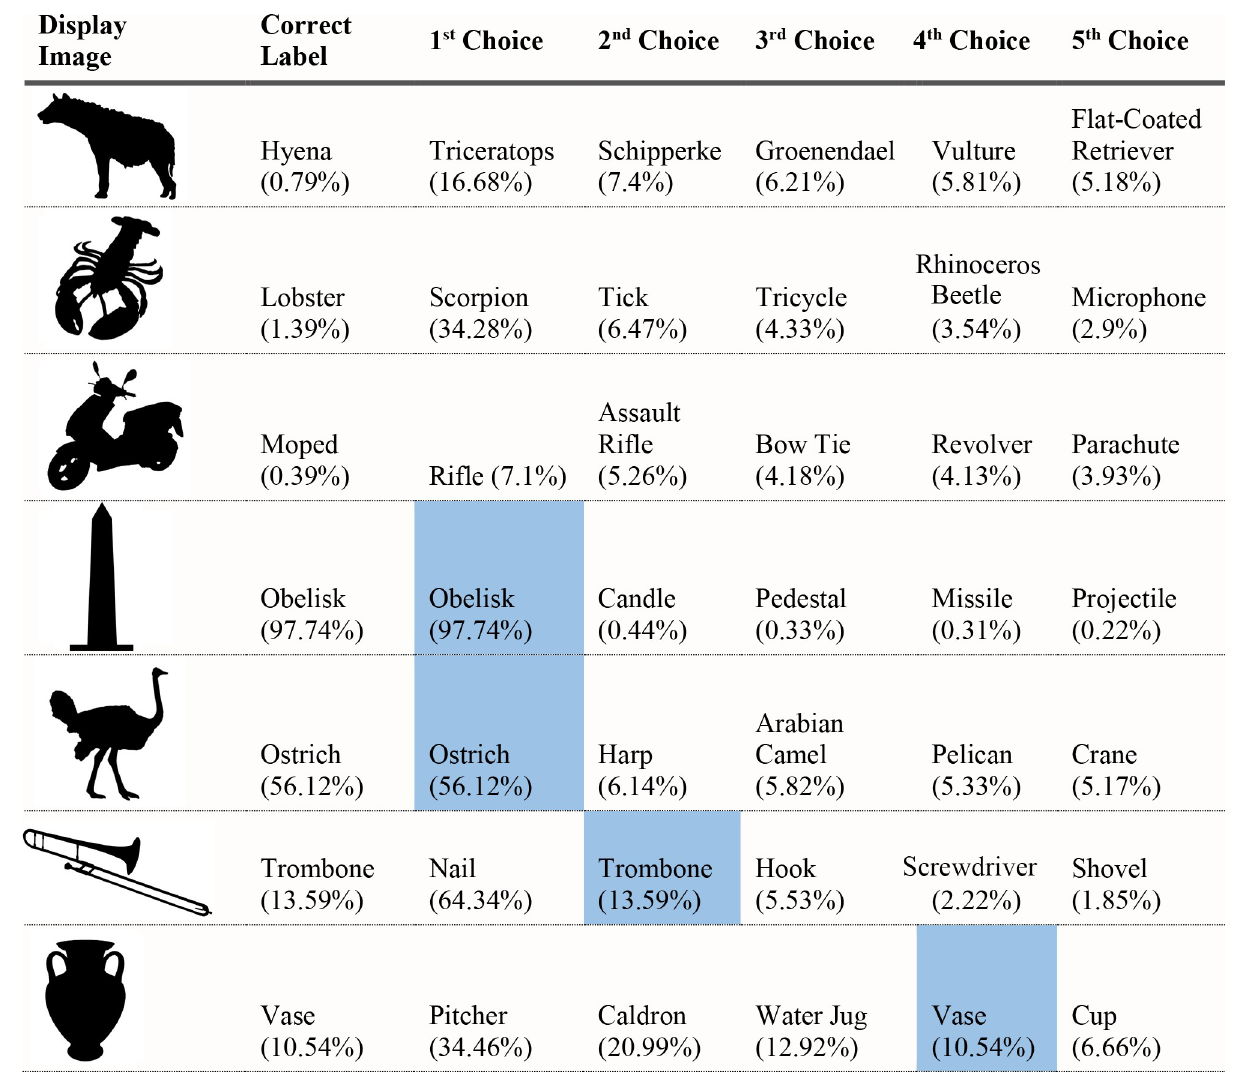
Fig 22. VGG-19 classifications for black object silhouettes Part